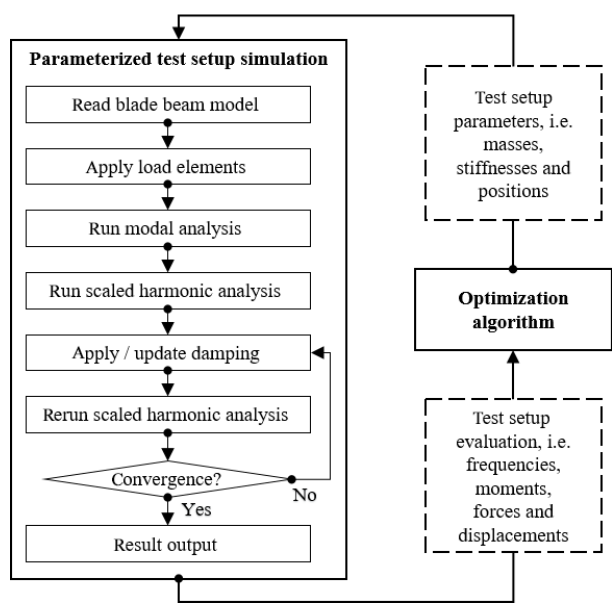
Figure 4. Flow chart of simulation sequence and